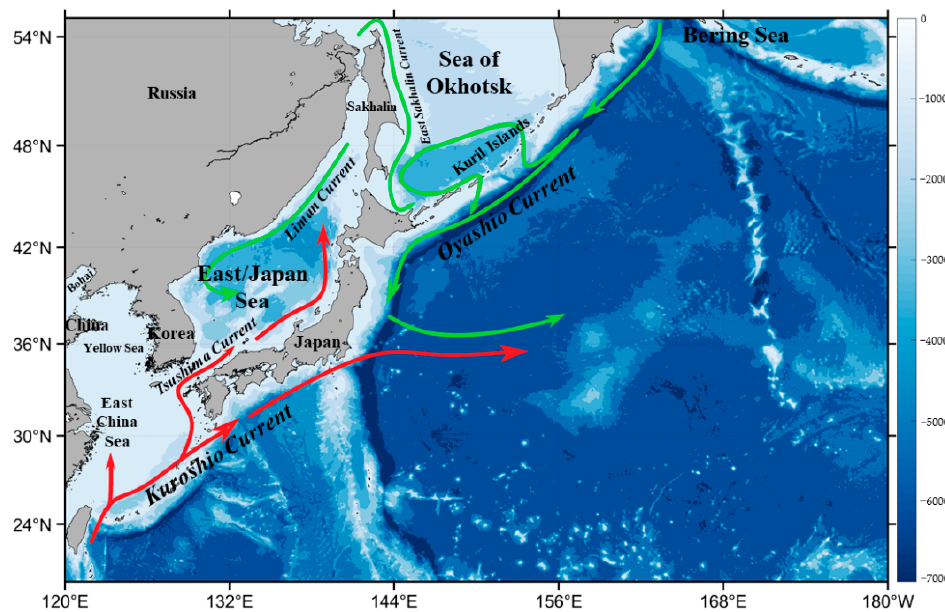
Figure 1. Bathymetric map (unit: m) of the northwest Pacific, based on the ETOPO2 bathymetry, with red lines representing warm currents and green lines representing cold currents.